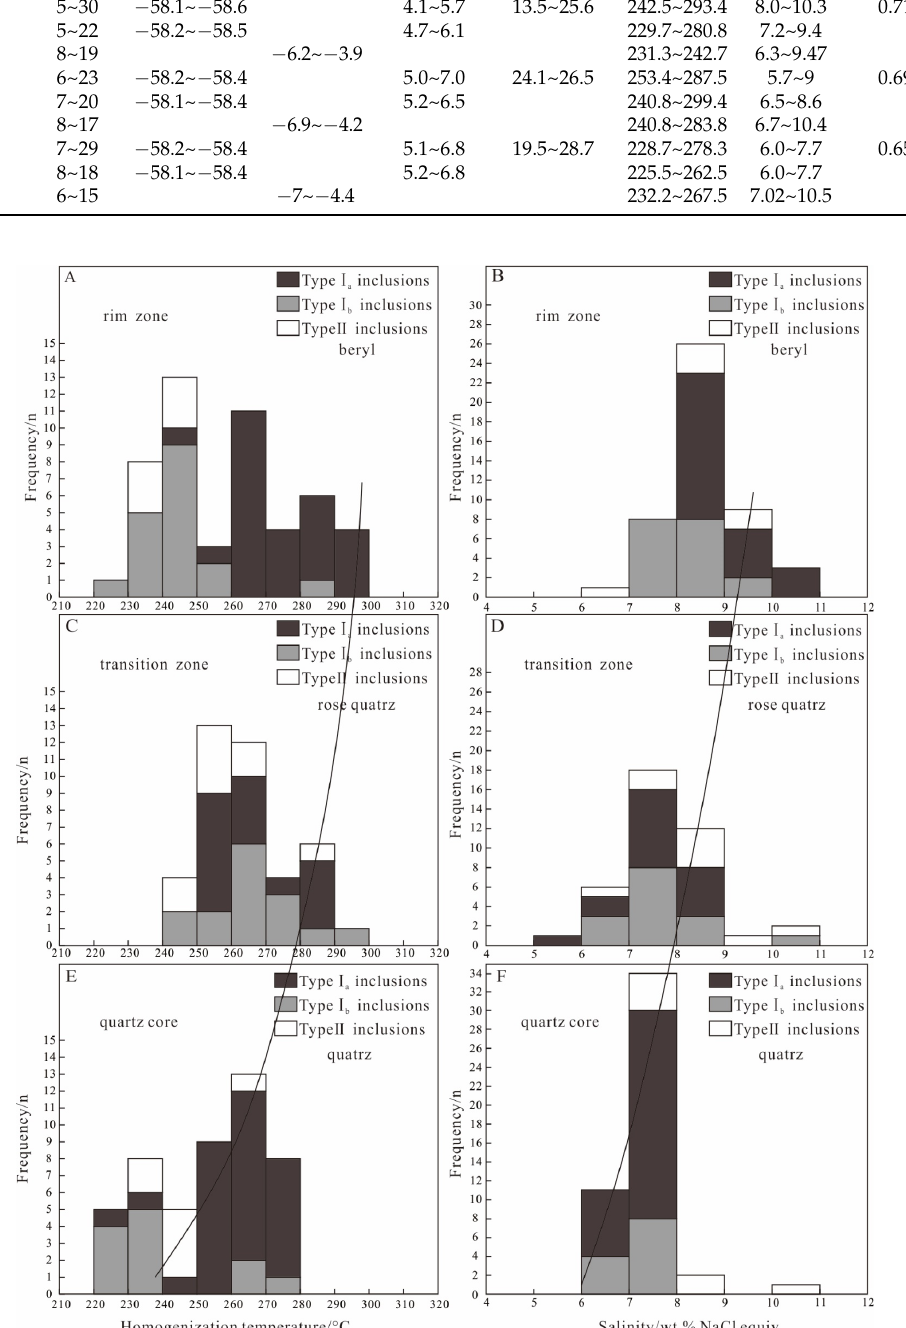
Figure 7. Homogeneous temperature and salinity histogram of the fluid inclusions from Dakalasu No. 1 pegmatite vein. ( A , B ) Histogram of homogenization temperature and salinity of fluid inclusions in beryl; ( C , D ) Histogram of homogenization temperature and salinity of fluid inclusions in in rose quartz; ( E , F ) Histogram of homogenization temperature and salinity of fluid inclusions in quartz.